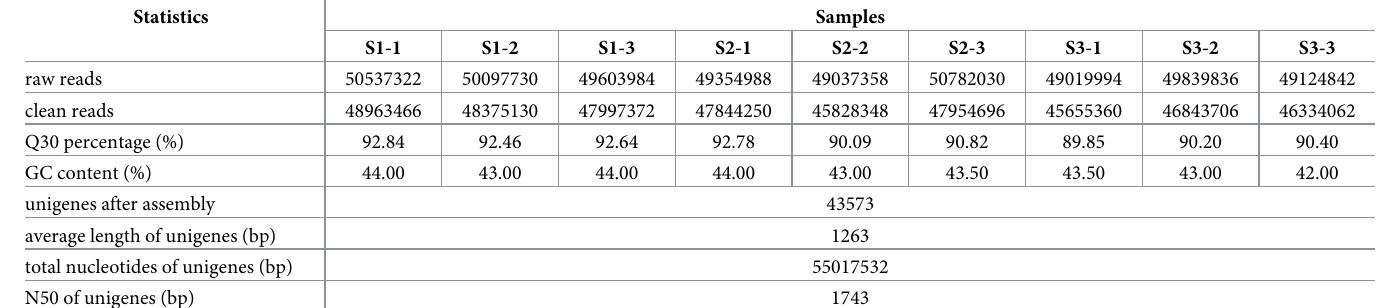
Table 1. Summary of sequencing and de novo